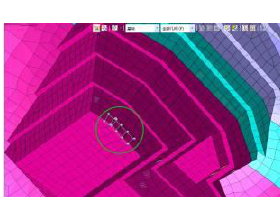
Figure 9. Vibration velocity test point on the foundation pit.